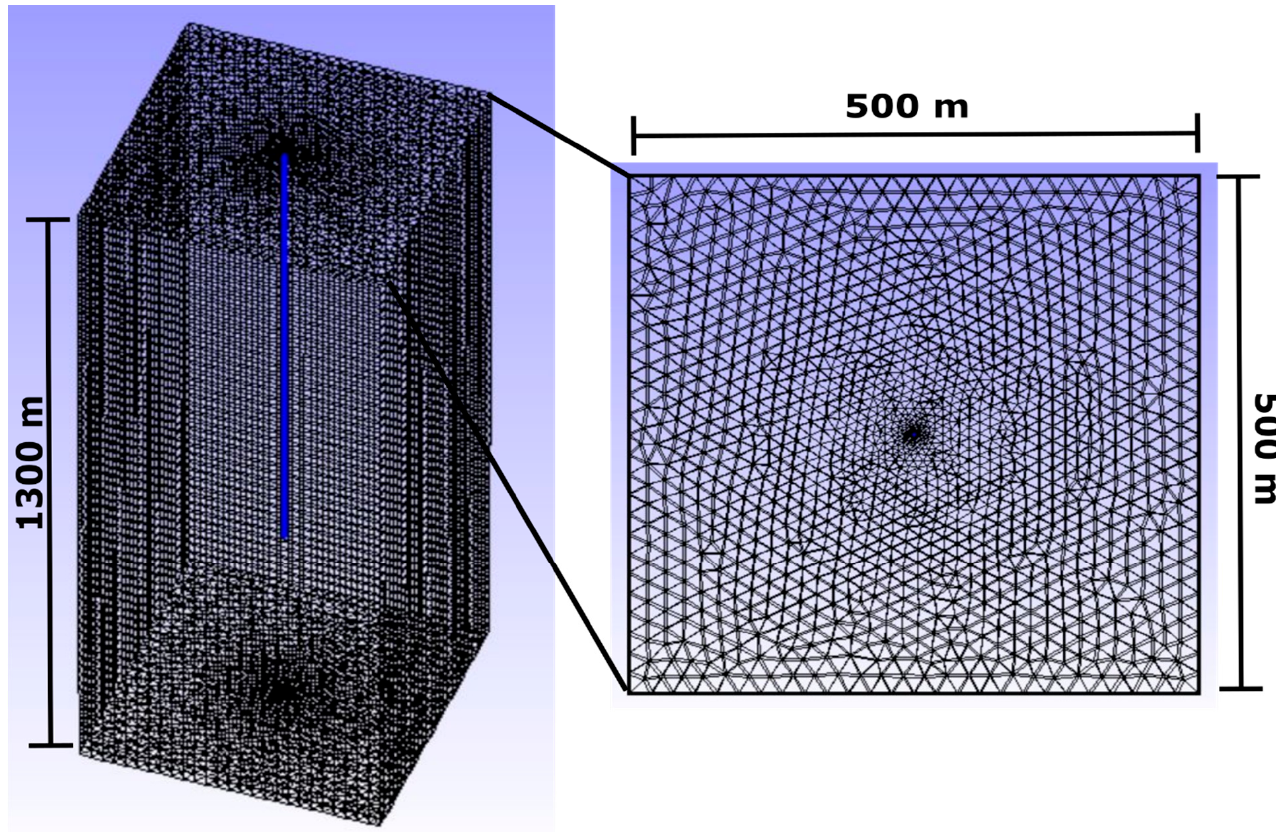
Figure 3. Example fully discretised mesh and domain size.